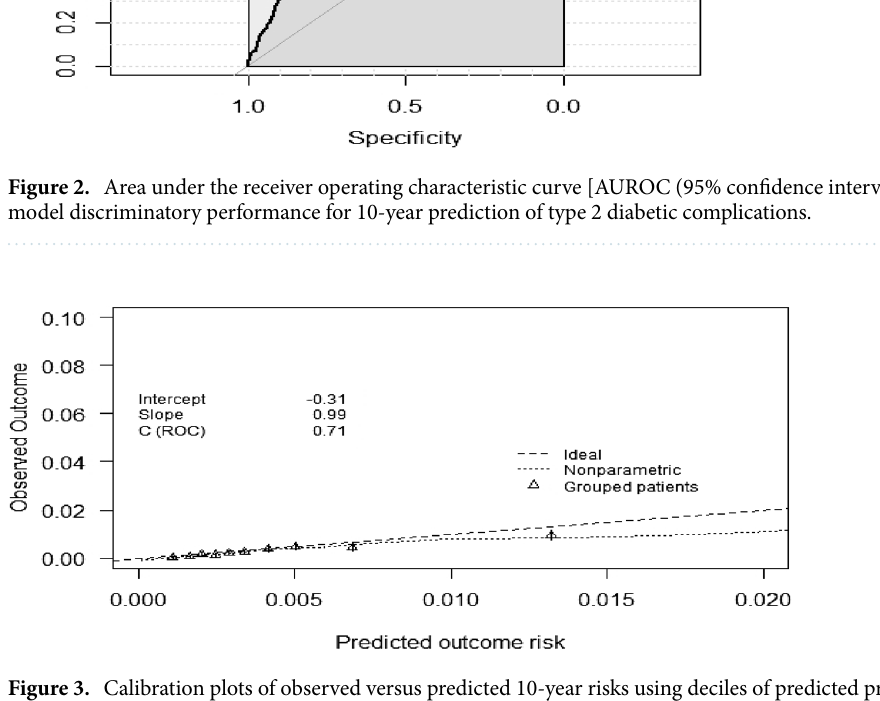
Figure 3. Calibration plots of observed versus predicted 10-year risks using deciles of predicted probability for type 2 diabetic complications.